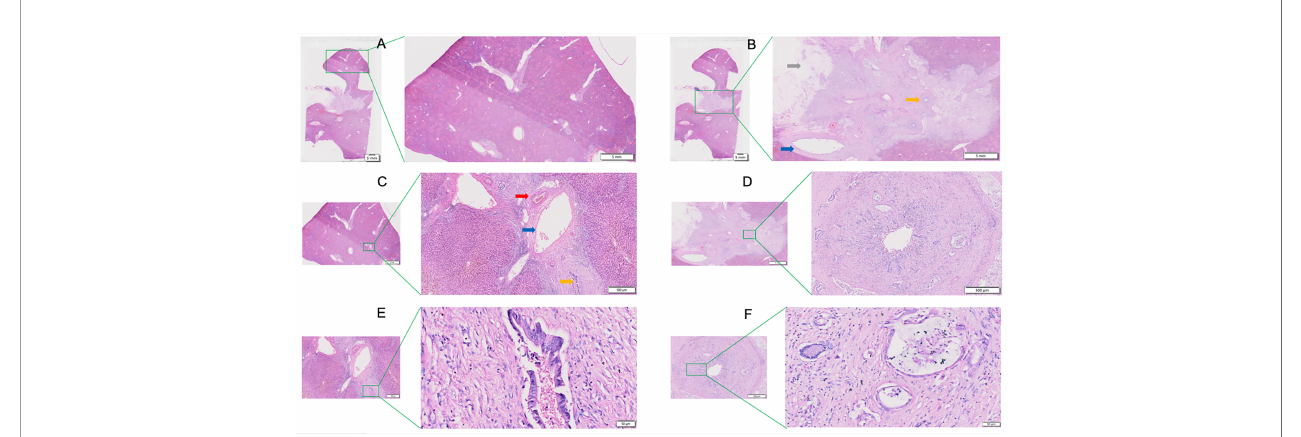
FIGURE 2 | View of the caudate lobe by WHLS in HCCA. (A) Large portal areas visible within caudate lobes. Scale bar, 5 mm. (B) Tissues in the hilar region including portal vein (blue arrow), bile duct (yellow arrow), adipose tissue(grey arrow). Scale bar, 5 mm. (C) Arterioles (red arrow), portal vein (blue arrow), and bile ducts (yellow arrow) in caudate lobular portal area. Scale bar, 500um. (D) Cancerous bile duct. Scale bar, 500 µm. (E) Bile ducts in caudate lobular portal area. Scale bar, 50 µm. (F) Adenocarcinoma in cancerous bile duct. Scale bar, 50 µm.